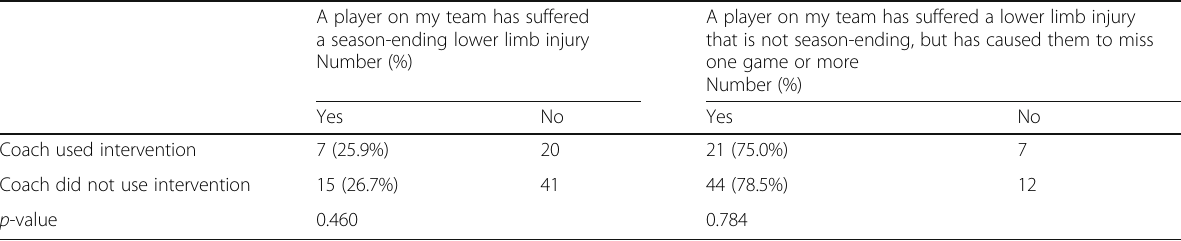
Table 1 Injury incidence vs use of intervention